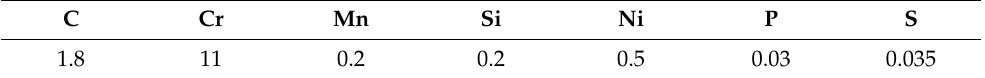
( b ) Figure 4. Wear of the active parts of the half-trimming dies: ( a )—accentuated wear, disposed approximately symmetrical on the entire length of the active part; ( b )—accentuated asymmetrical wear. Because the efforts in the material are very high, the trimming die deforms elastically 3–4 mm during each cleaning operation, and the maximum wear of the active part that can be allowed usually occurs approximately, in the case of their production from X210Cr12 steel, after 36–48 operating h, i.e., after N = 340,000–350,000 load cycles. Due to the fact that the maximum wear of the active part of the cleaning trimming dies occurs after a very short time of use, the aim of the research was to find a technological solution to increase the durability of the trimming dies. In this sense, the research addressed several technically possible solutions, namely: •